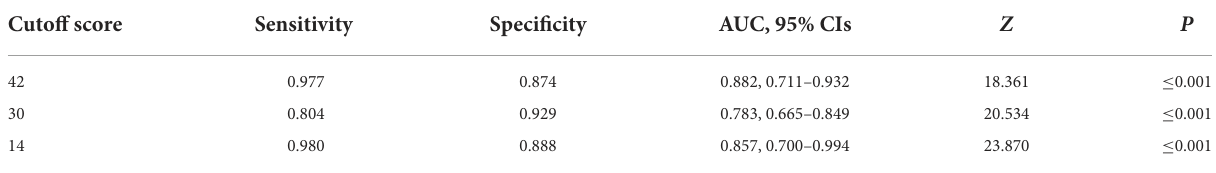
TABLE 2 Cutoff scores of